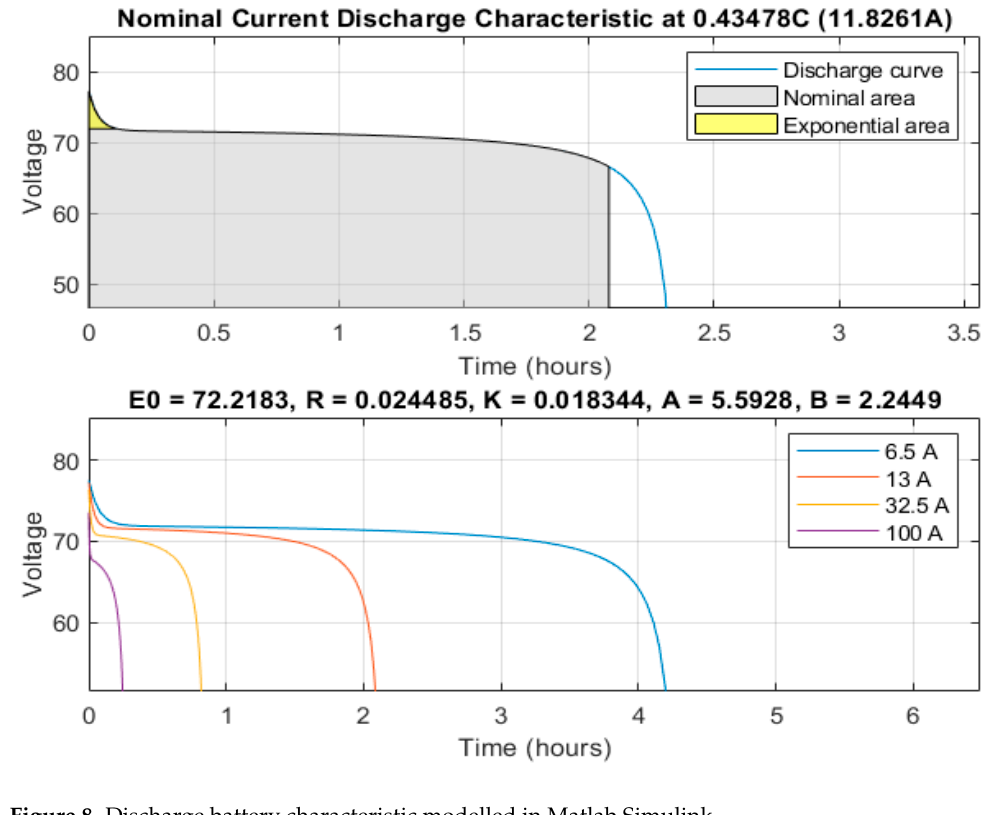
Figure 8. Discharge battery characteristic modelled in Matlab Simulink.